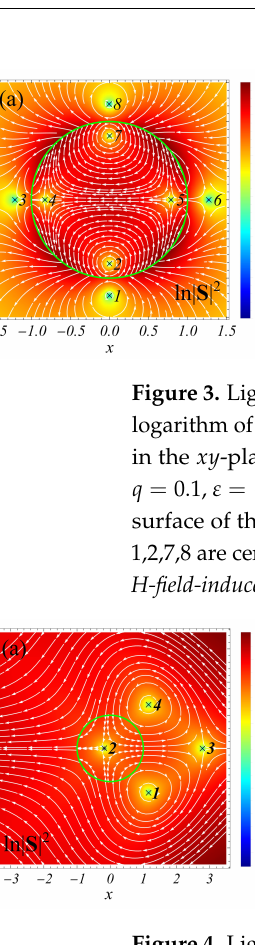
Figure 4. Light scattering by a cylinder in a vacuum. Streamlines for the Poynting vector field and the logarithm of the square of the modulus of the Poynting vector ( a ), electric ( b ), and magnetic ( c ) fields in the xy -plane. The TM polarization (vector H of the incident wave lies in the plane of the figure) and q = 0.3, ε = 16. Points 1 and 4 are centers; the rest are saddles. | S | 2 = 0 at all singular points. The centers and saddles are the E-field-induced and polarization-induced singularities , respectively. See text for